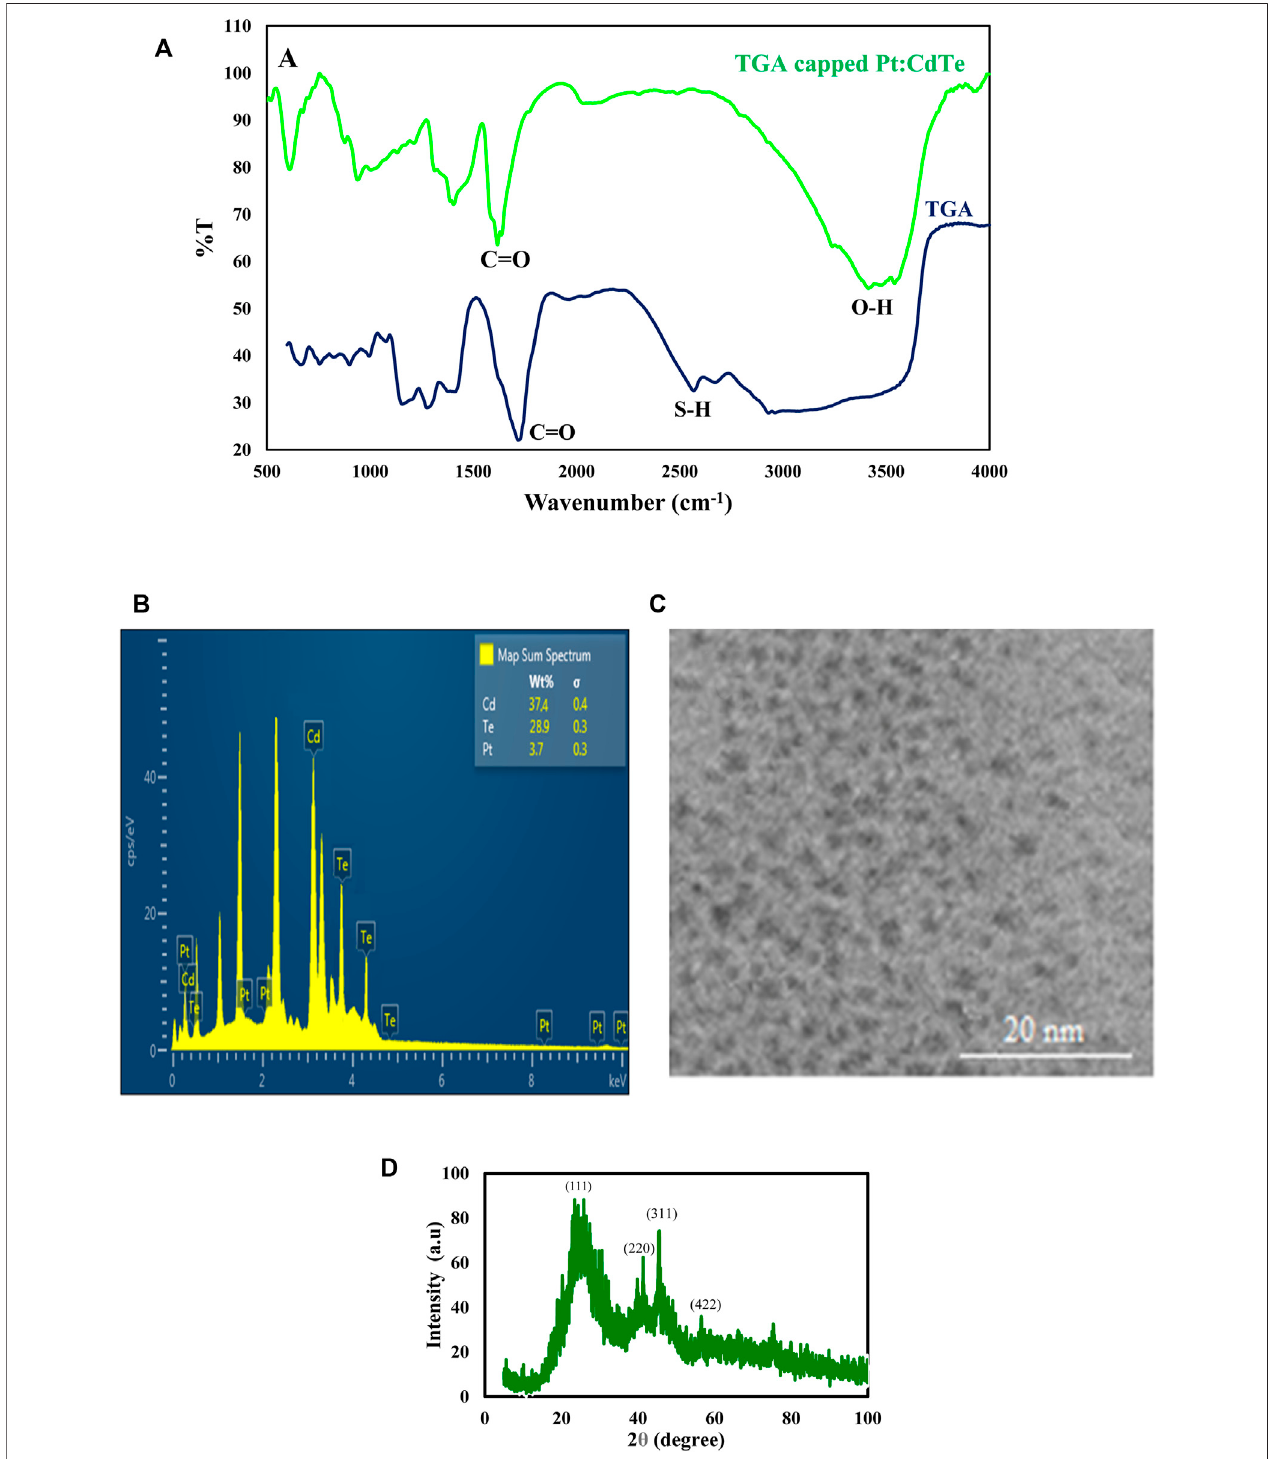
FIGURE 2 | (A) FT-IR spectra of Pt: CdTe NPs and TGA (B,C) TEM image and EDX spectrum of Pd: CdTe NPs (D) XRD patterns of Pt:CdTe QDs.